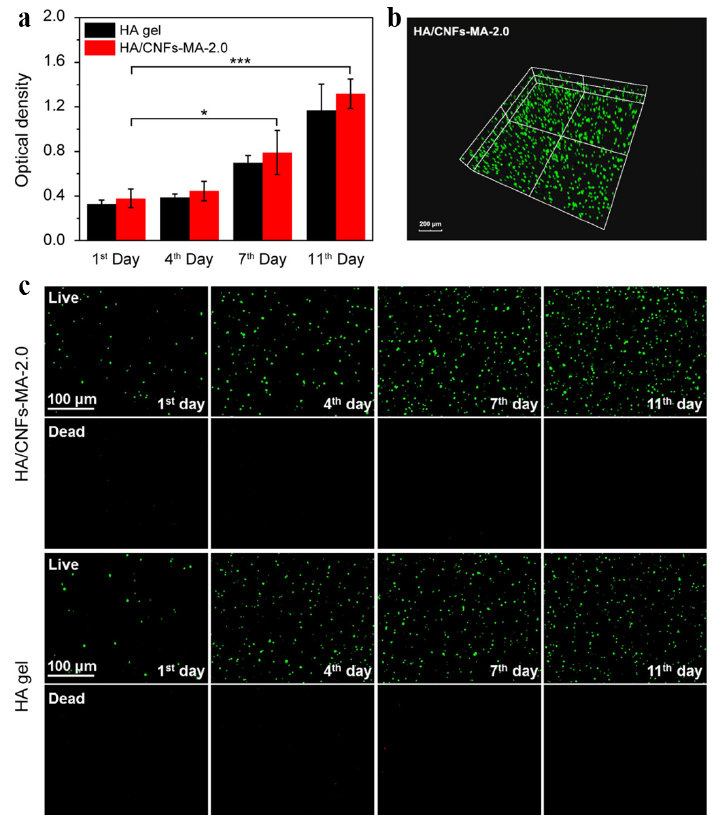
Figure 14. ( a ) The proliferation of BMSCs within the hydrogels at certain time points. ( b ) Three- dimensional distribution of BMSCs in the HA/CNFs-MA-2.0 nanocomposite hydrogel on the seventh day. ( c ) Live/dead staining of BMSCs in the HA hydrogel and the HA/CNFs-MA-2.0 nanocomposite hydrogel at certain time points, respectively. Data reproduced from ref.